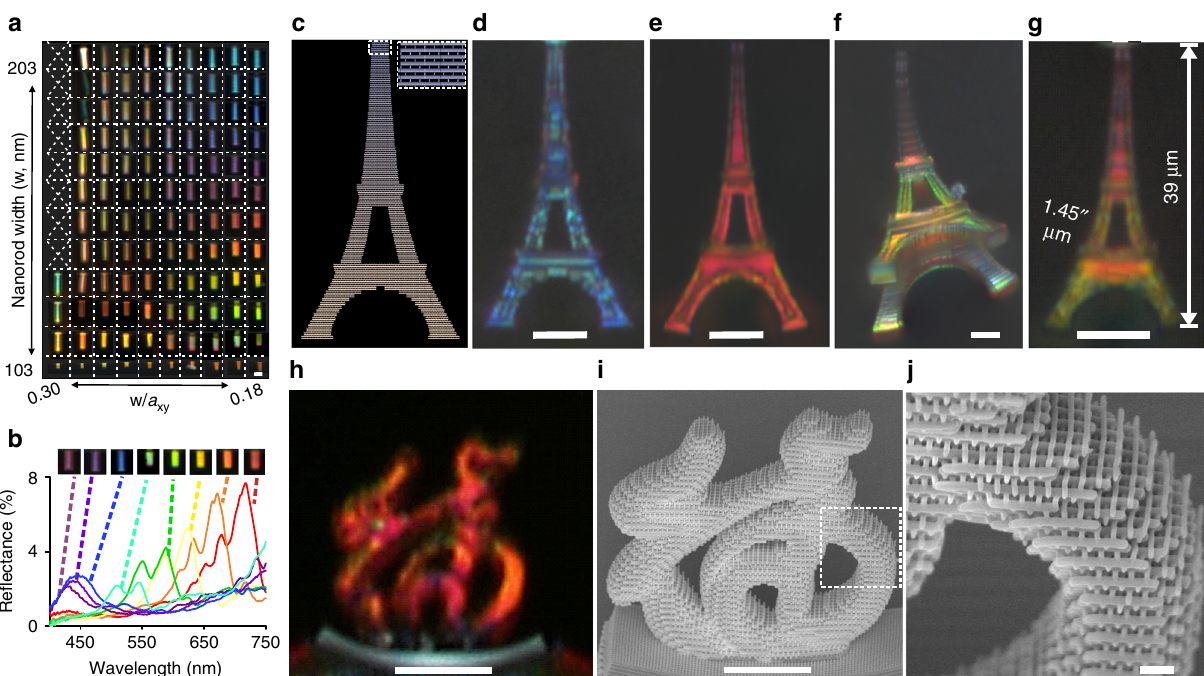
Fig. 4 3D color prints. a Composite optical micrographs of heat-treated woodpile photonic crystals with varying structural dimensions as viewed from the side. b Side illumination re fl ectance spectra of selected woodpile structures from a . c General Writing Language fi le used for lithographic printing of the Eiffel Tower, comprising of woodpile voxels. Micrographs of 3D-printed model of the Eiffel Tower in structural blue ( d ) and structural red ( e ). f Oblique view of an Eiffel Tower printed with intentional gradient of colors. g Further down-scaled multi-color 3D print of the Eiffel Tower. h Optical micrograph and i SEM image of a 3D Chinese character “ 福 ” in structural red. j Close-up SEM image of dotted square region in i . Scale bars in a – i represent 10 μ m and scale bar in j represents 1 μ